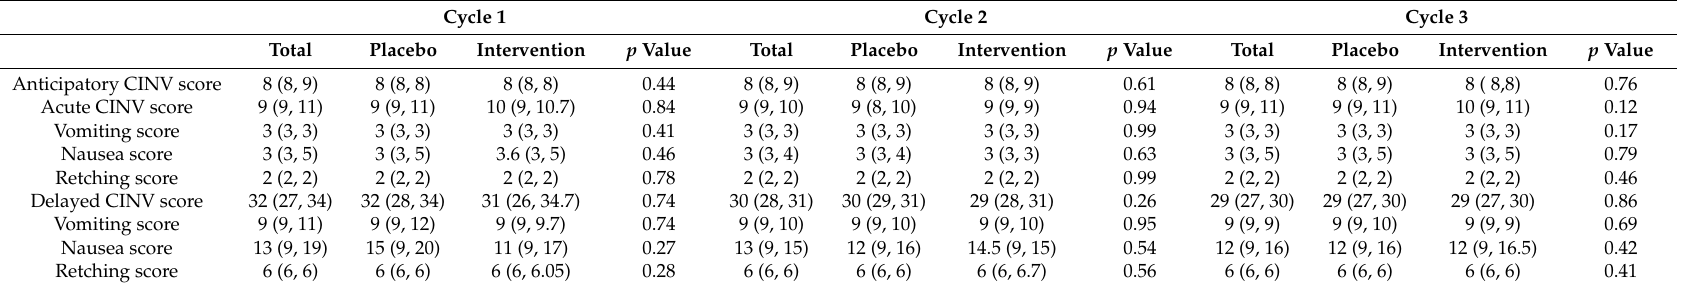
Table 3. Participant Inventory of Nausea, Vomiting and Retching (INVR) questionnaire scores and CINV prevalence.